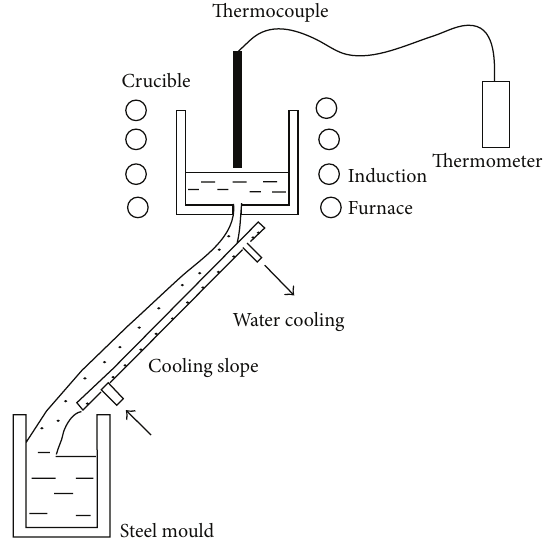
Figure 14: Schematic illustration of the stages of the cooling slope technique [35].